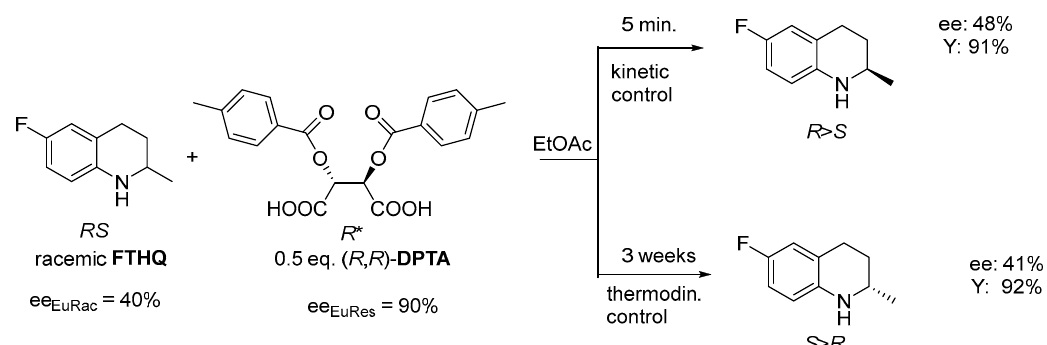
Figure 11. The enantiomeric mixture, taking part in the formation of the diastereomer present in the crystalline phase, alters in the function of the crystallization time.